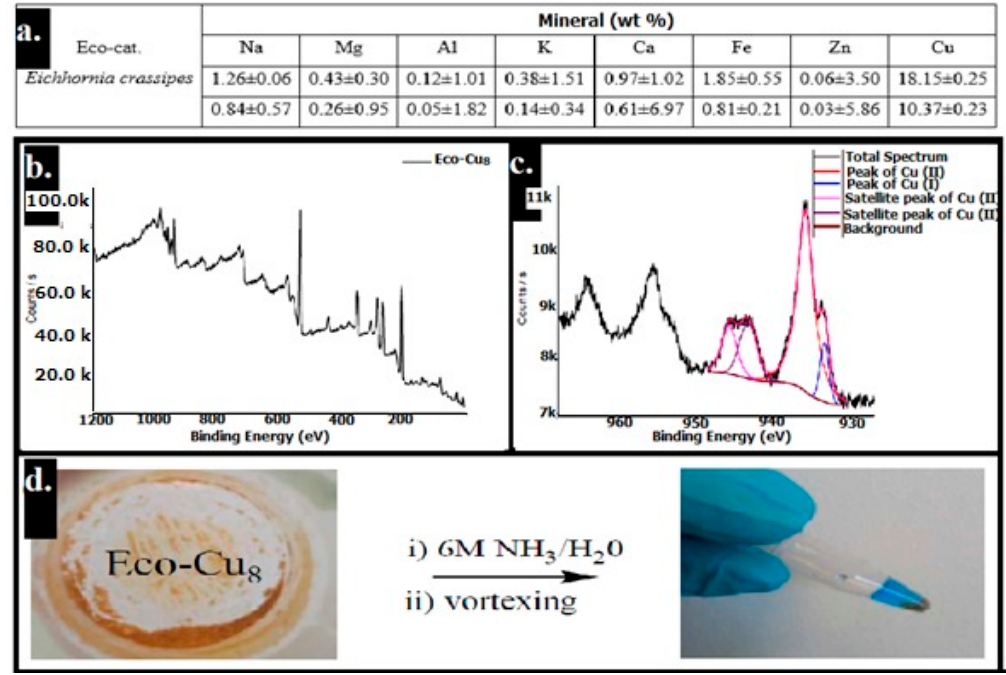
Figure 2. ( a ) Chemical composition on the eco-Cu-NPs Eichhornia crassipes ; ( b , c ) the XPS analysis of eco-Cu-NPs; ( d ) The analytical characterization eco-Cu-NPs. Reproduced by permission of Royal Society of Chemistry. [40]